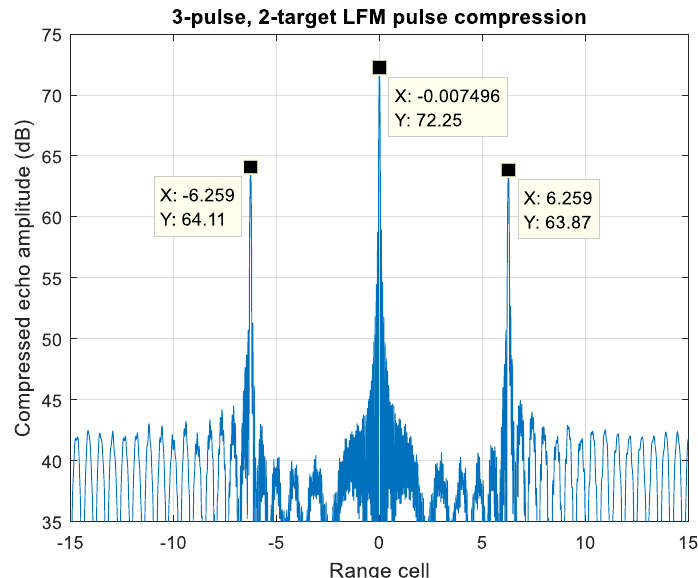
Figure 20. Pulse compressed echo of two overlapped targets. Target-one is zero Doppler, while target-two velocity is at Mach 15.